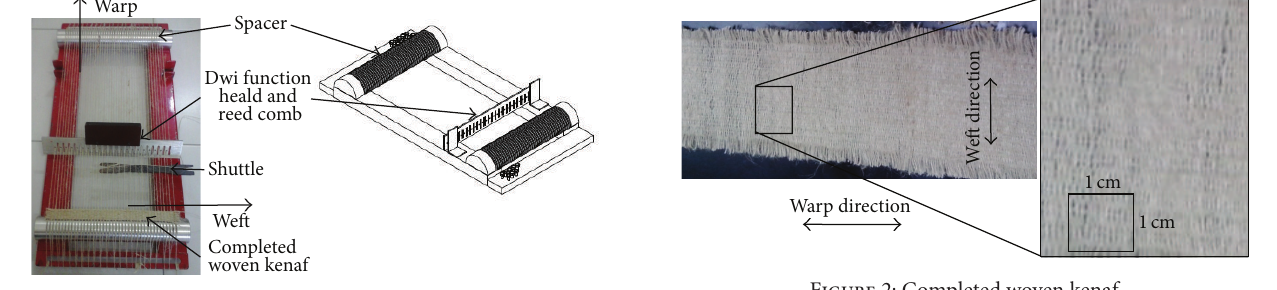
Figure 1: Self-design handloom.